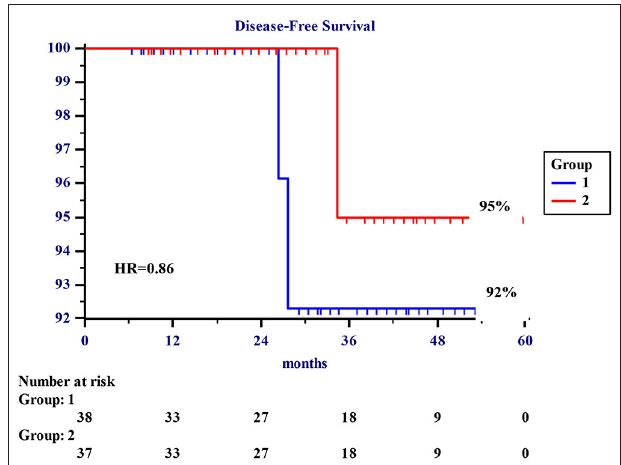
TABLE 1 | Characteristics of the series and results.